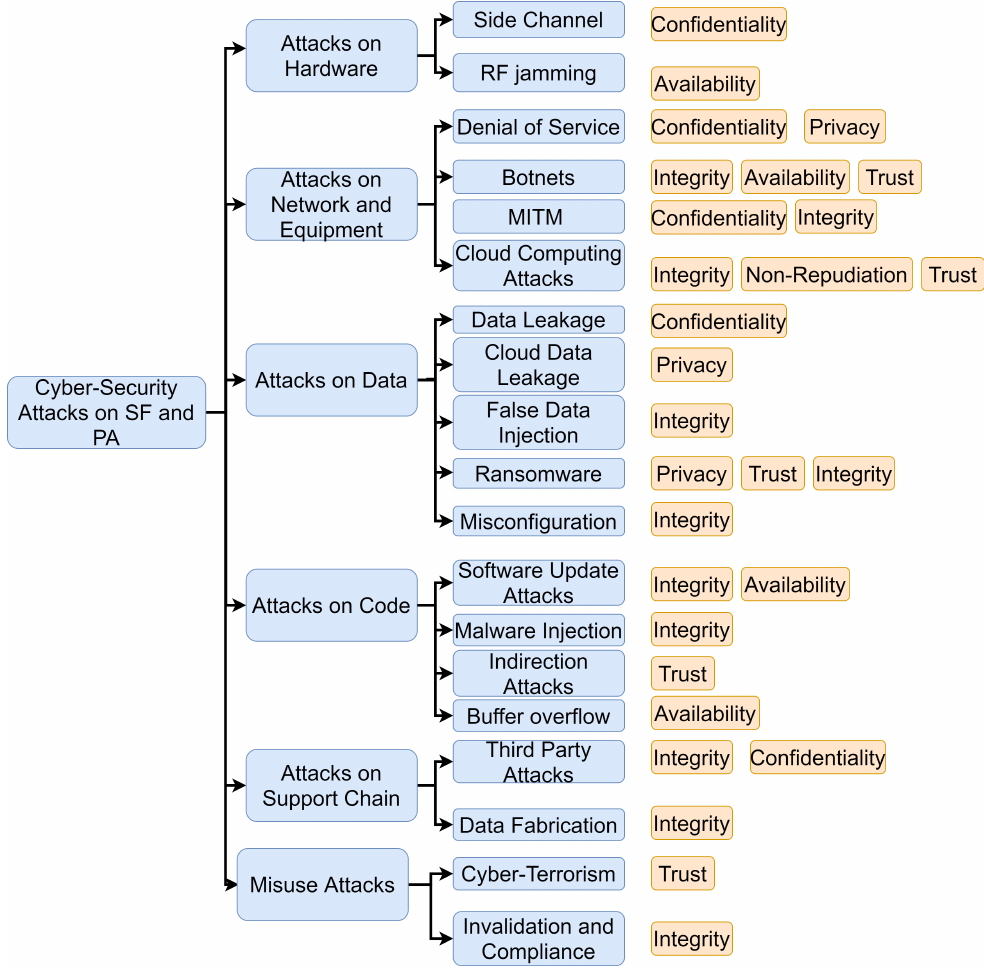
Figure 2. Classification of attacks on SF and